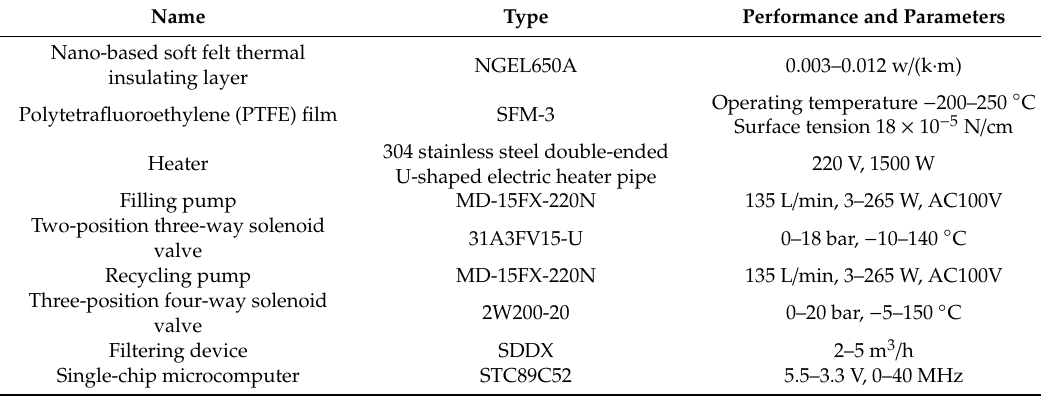
Figure 12. The basic prototype. Table 4. Main materials that make up this prototype.